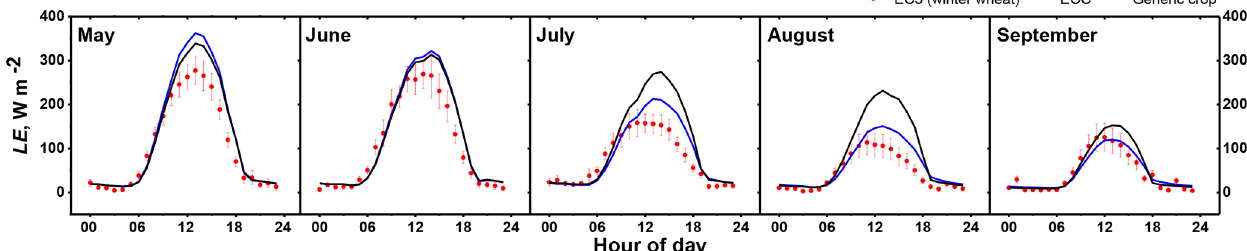
Figure 4. Monthly averaged measured and simulated diurnal latent heat flux ( LE ) for May–September. The Noah-MP LSM was run with two different vegetation parametrizations: early-covering crops (ECC) and generic crop.